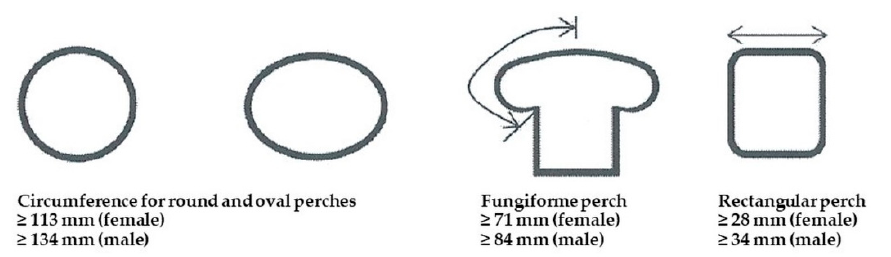
Figure 5. Recommended perch design for broiler breeders based on the results of this study (Illustration: A. Brandes; modified from the implementation instructions of TierSchNutzV).